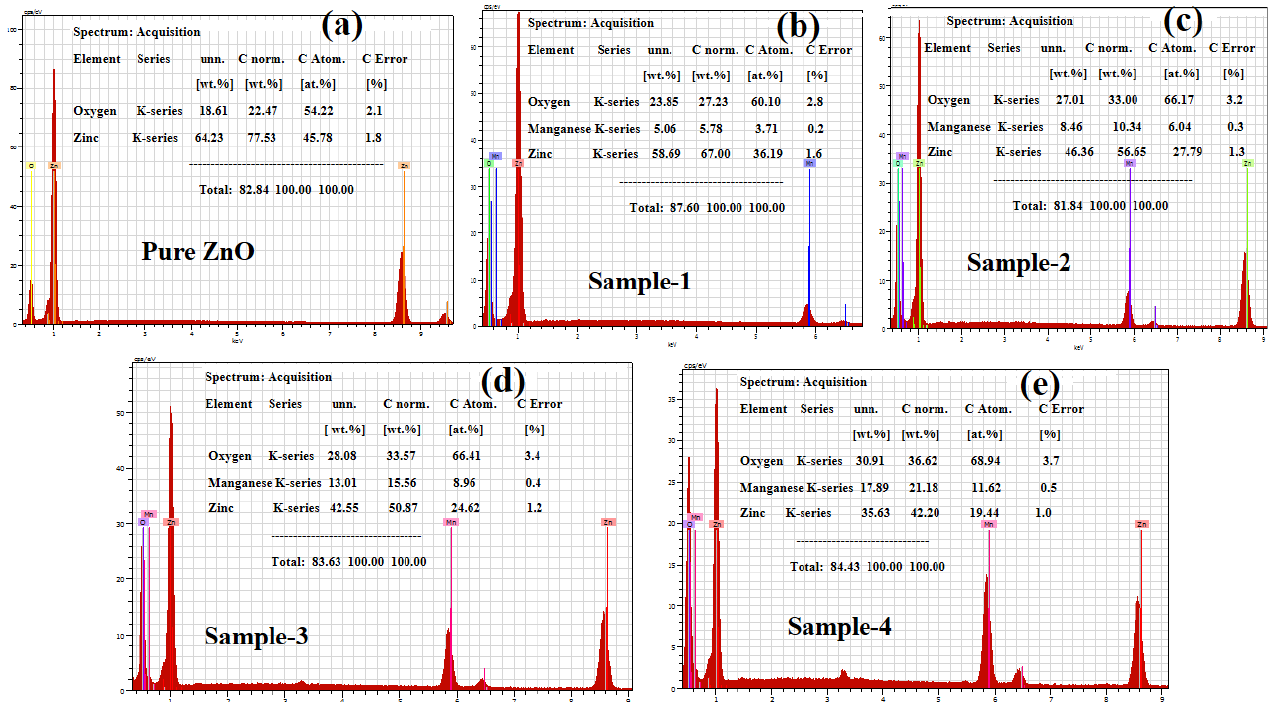
Figure 2. SEM images of ( a ) pristine ZnO and ( b – e ) Mn 3 O 4 @ZnO materials synthesized by sol-gel method.